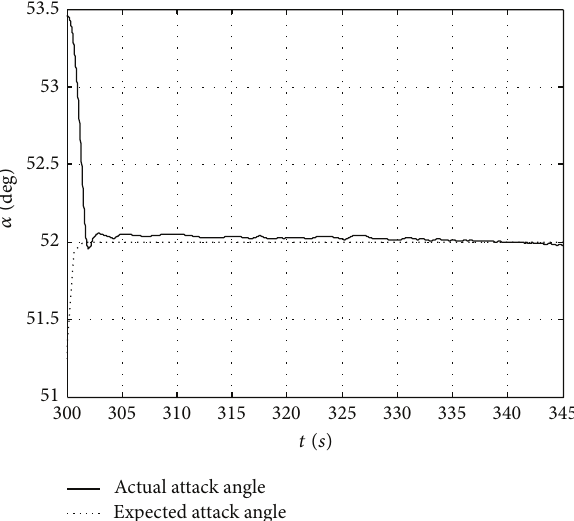
Figure 13: Simulation result of yaw angle.